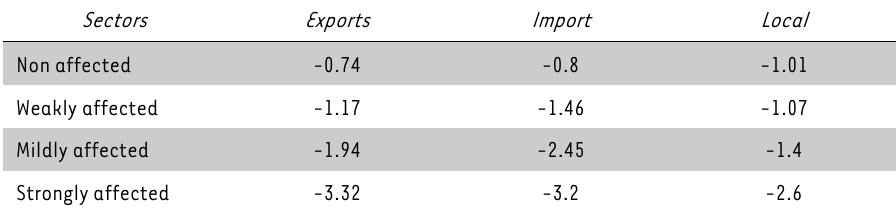
TABLE 1: Impact on prices (in %) Sectors Exports Import Local